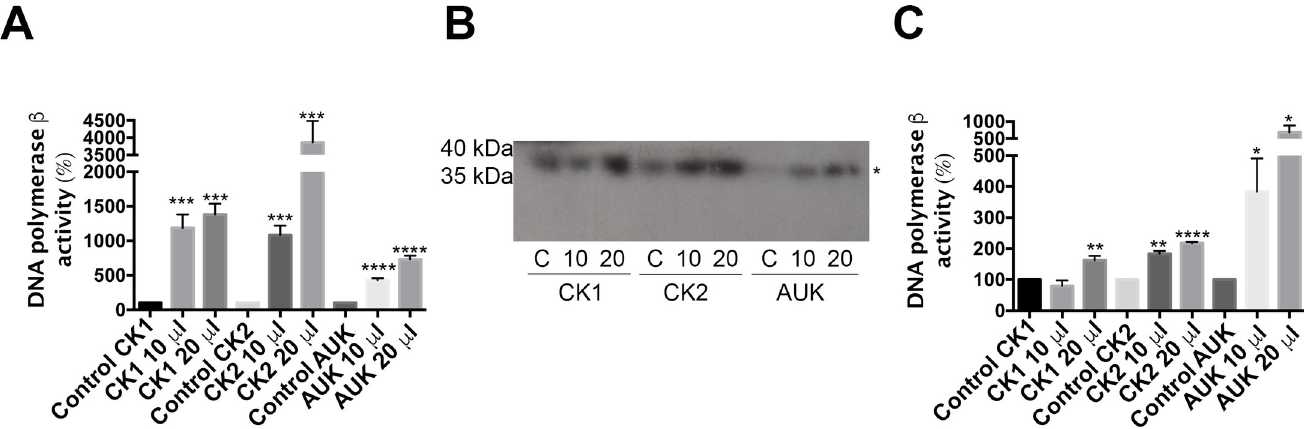
Fig 6. The phosphorylation state of Tcpol β by the studied protein kinases increases its polymerizing activity. A) Liquid scintillation assay. In this experiment, 20 ng of Tcpol β were incubated with the indicated kinases, without ATP for controls (with 20 pmol of each protein kinase), and with 10 and 20 pmol of each indicated kinase enzyme. After 30 minutes the reaction was spotted in a DE81 paper piece and processed as indicated in Materials and Methods. It can be observed a high stimulation of the polymerizing activity of the phosphorylated Tcpol β . B) To further confirm this activity an identical experiment as in A was done, but the reaction was loaded in an activity SDS-PAGE gel. The results are showed and is observed that CK1, CK2 and TcAUK1 are capable to stimulate the polymerizing activity of Tcpol β . C) Quantification plot of the experiment in B). Results are expressed in arbitrary units and represent the mean +/- SD of three independent experiments. Significance is defined as p < 0.05 when the mean of the experiments is compared with the respective control assay (CK1, CK2 and TcAUK1). � indicates p < 0.05, �� indicates p < 0.01, ��� indicates p < 0.001 and ���� indicates p < 0.0001.